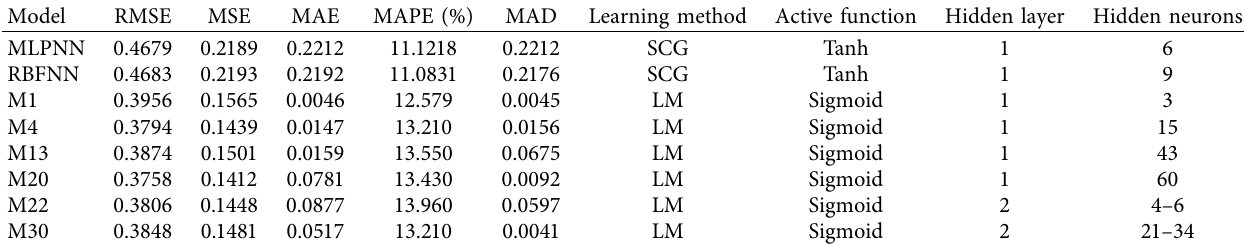
Table 18: Performance comparison between the mathematical models and machine learning models. Model